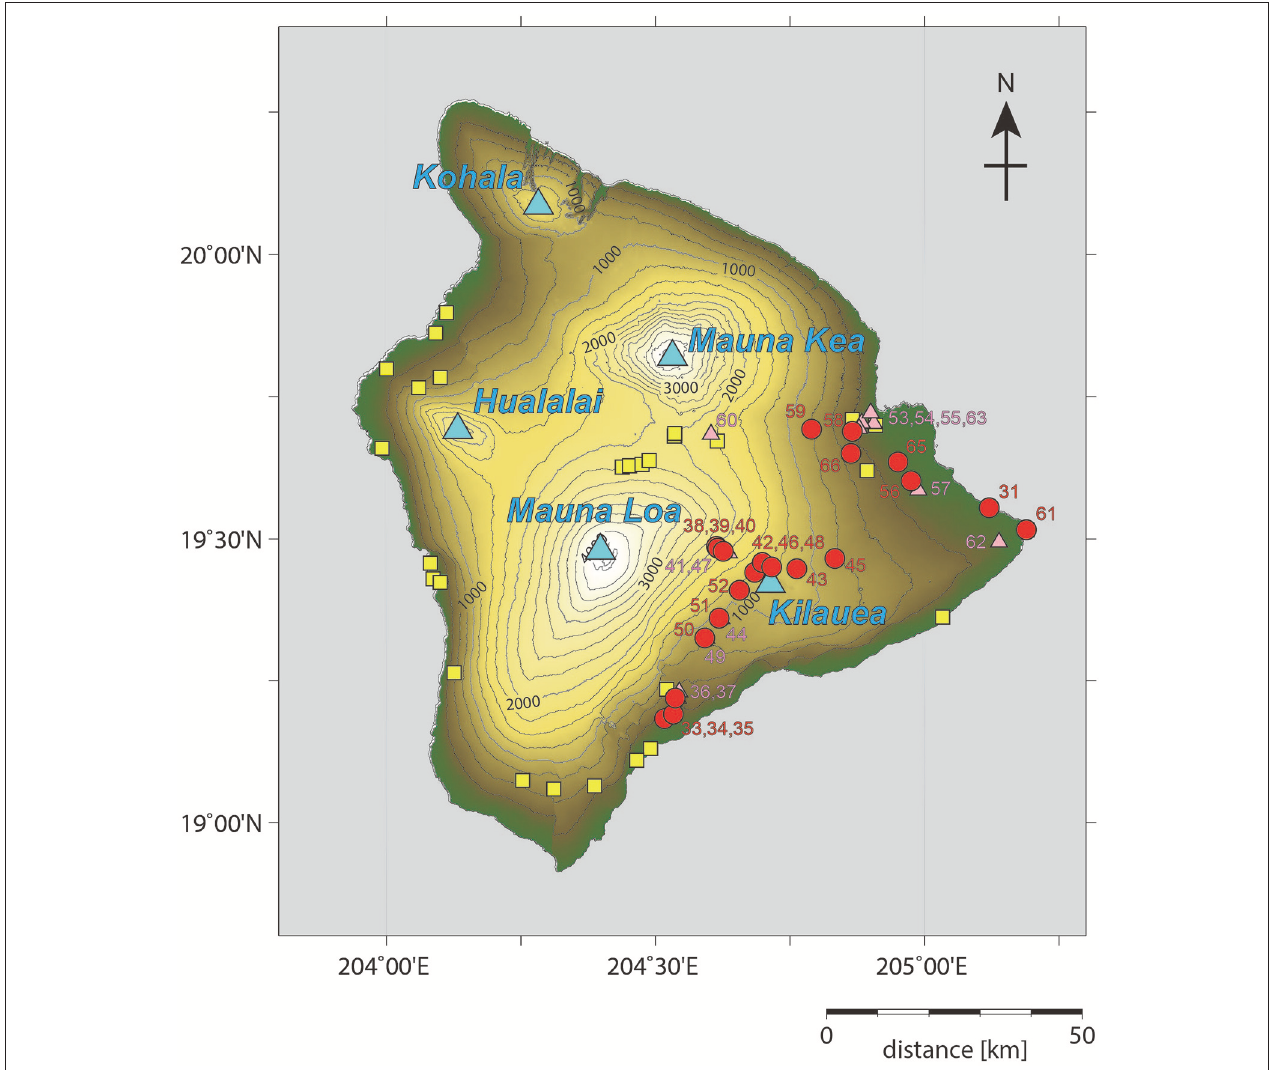
FIGURE 1 | Map showing the sampling sites of the Holocene surface lavas on the island of Hawaii. The sites are indicated by red circles (adopted for the TS dataset, section Tsunakawa–Shaw Paleointensity) and pink triangles (not adopted for the TS dataset) for this study (detailed locations are listed in Table 1 ) together with their site numbers. The sites for Cromwell et al. (2015, 2017) are also shown by yellow squares (adopted for the IZZI